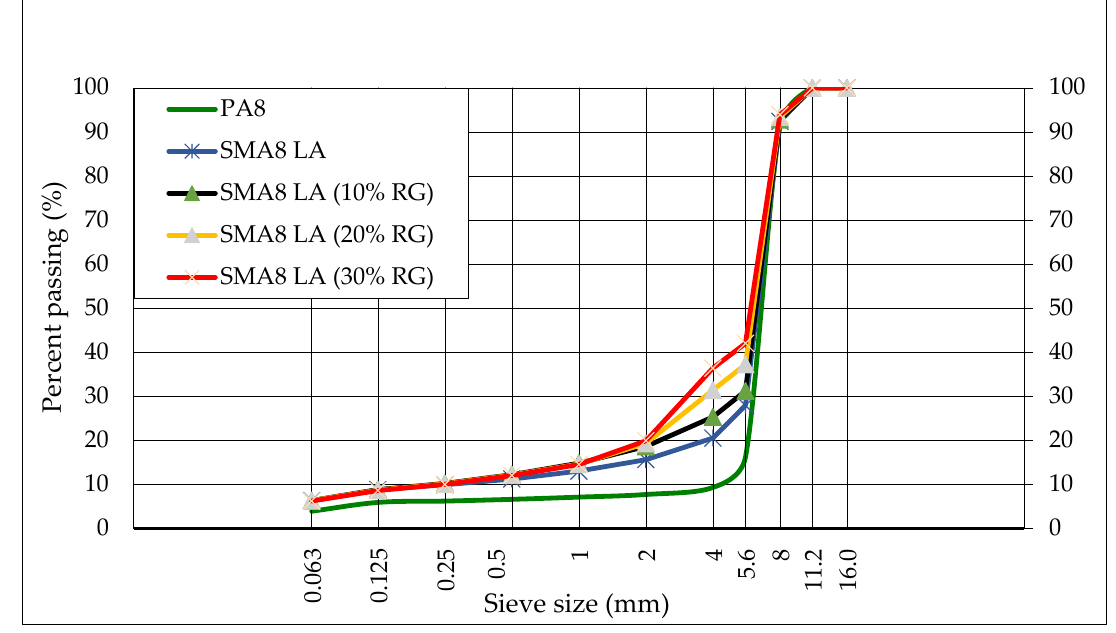
Figure 1. The particle size distribution of tested mixtures. Table 3. The characteristics of tested mixtures.